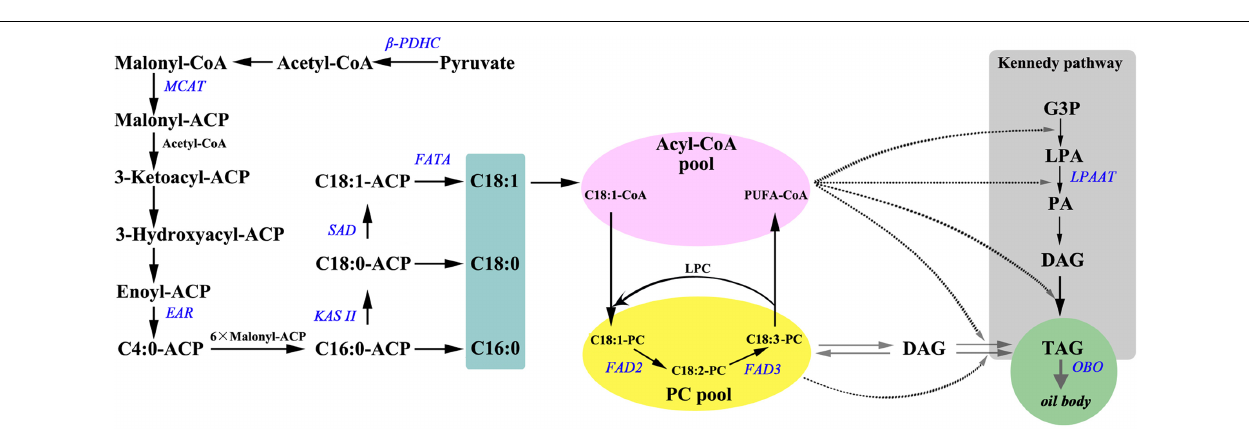
expression levels at S3 in P. rockii , relative to its S1 were 25-fold higher for β -PDHC and 5-fold higher for MCAT (